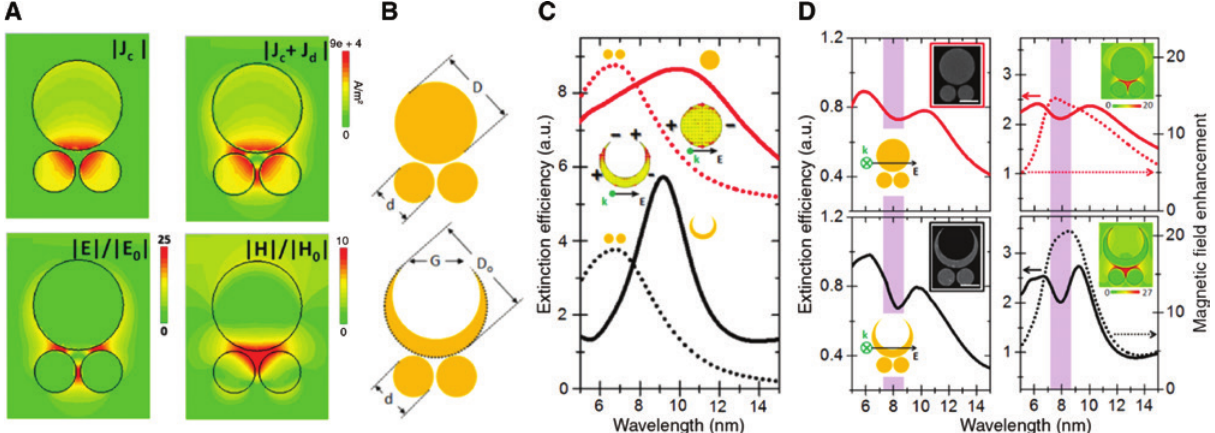
Figure 4: Coil-like dark modes and plasmonic hybridization involving high order modes. (A) 2D plots of conduction current density (top left) and total charge current density, i.e. conduction plus displacement current (top right), together with the electric (bottom left) and magnetic field enhancement (bottom right) at the Fano resonance. Adapted with permission from Nazir A, Panaro S, Proietti Zaccaria R, Liberale C, De Angelis F, Toma A. Fano coil-type resonance for magnetic hot-spot generation. Nano Lett 2014;14:3166–71 (Ref. [96]). Copyright 2014 American Chemical Society. (B) Sketches depicting the main morphological parameters of the disk (upper sketch) and moon (lower sketch) trimers. (C) The respective simulated extinction efficiency spectra of the disk dimer (dotted curve) and single disk (continuous curve) in the disk trimer (upper red curves) and the extinction efficiency spectra of the disk dimer (dotted curve) and moon structure (continuous curve) in the moon-integrated trimer (lower black curves). (D) Left, experimental extinction efficiency spectra associated with the respective arrays of disk trimer (red curve) and MTR (black curve), for normal incidence condition (see the left side insets for the polarization direction). The insets respectively show the SEM images of a single disk trimer (upper inset) and a single MTR (lower inset) (scalebar: 1 μ m). Right, respective simulated extinction efficiency spectra (solid lines) and magnetic field enhancement spectra (dotted lines) of the disk trimer array (red curves) and the MTR array (black curves). The insets show the 2D plots of the magnetic field enhancement distribution in the Fano resonance condition ( λ = 8 μ m). Adapted with permission from Panaro S, Nazir A, Proietti Zaccaria R, et al. Plasmonic moon: a Fano-like approach for squeezing the magnetic field in the infrared. Nano Lett 2015;15:6128–34 (Ref. [97]). Copyright 2015 American Chemical